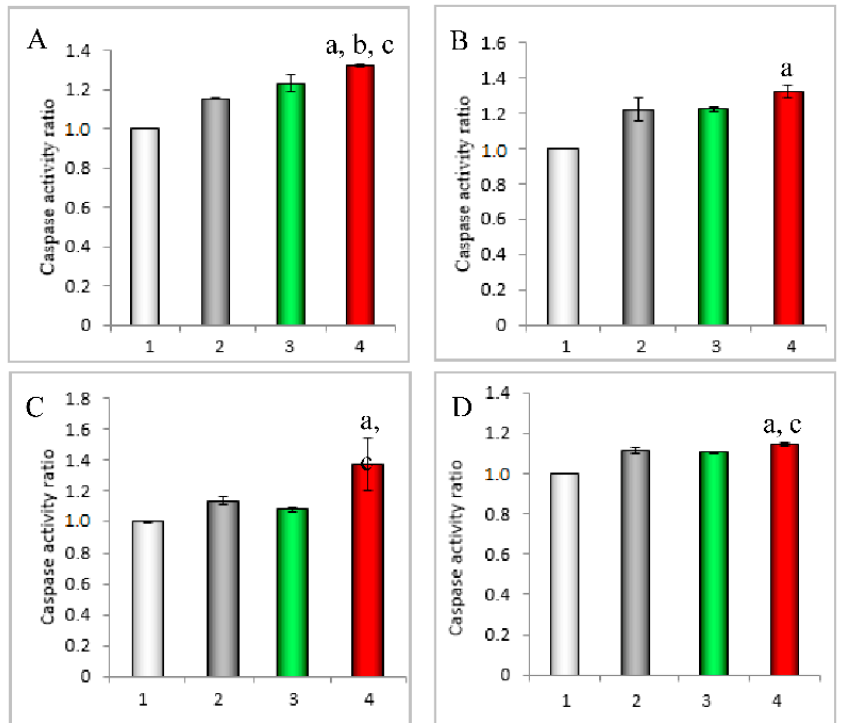
Figure 5. Activated caspase-8 and caspase-3 in leukemia BALL-1 cells and K562 cells by folate-overhung mitoxantrone DNA tetrahedra at 12 h ( A ). Caspase-8 activity ratio in BALL-1 cells; ( B ). Caspase-3 activity ratio in BALL-1 cells; ( C ). Caspase-8 activity ratio in K562 cells; ( D ). Caspase-3 activity ratio in K562 cells. For ( A–D) : 1. Blank; 2. PBS; 3. Mitoxantrone DNA tetrahedra; 4. Folate- overhung mitoxantrone DNA tetrahedra. a. vs. blank; b. vs. PBS; c. vs. mitoxantrone DNA tetrahedra, p < 0.05.